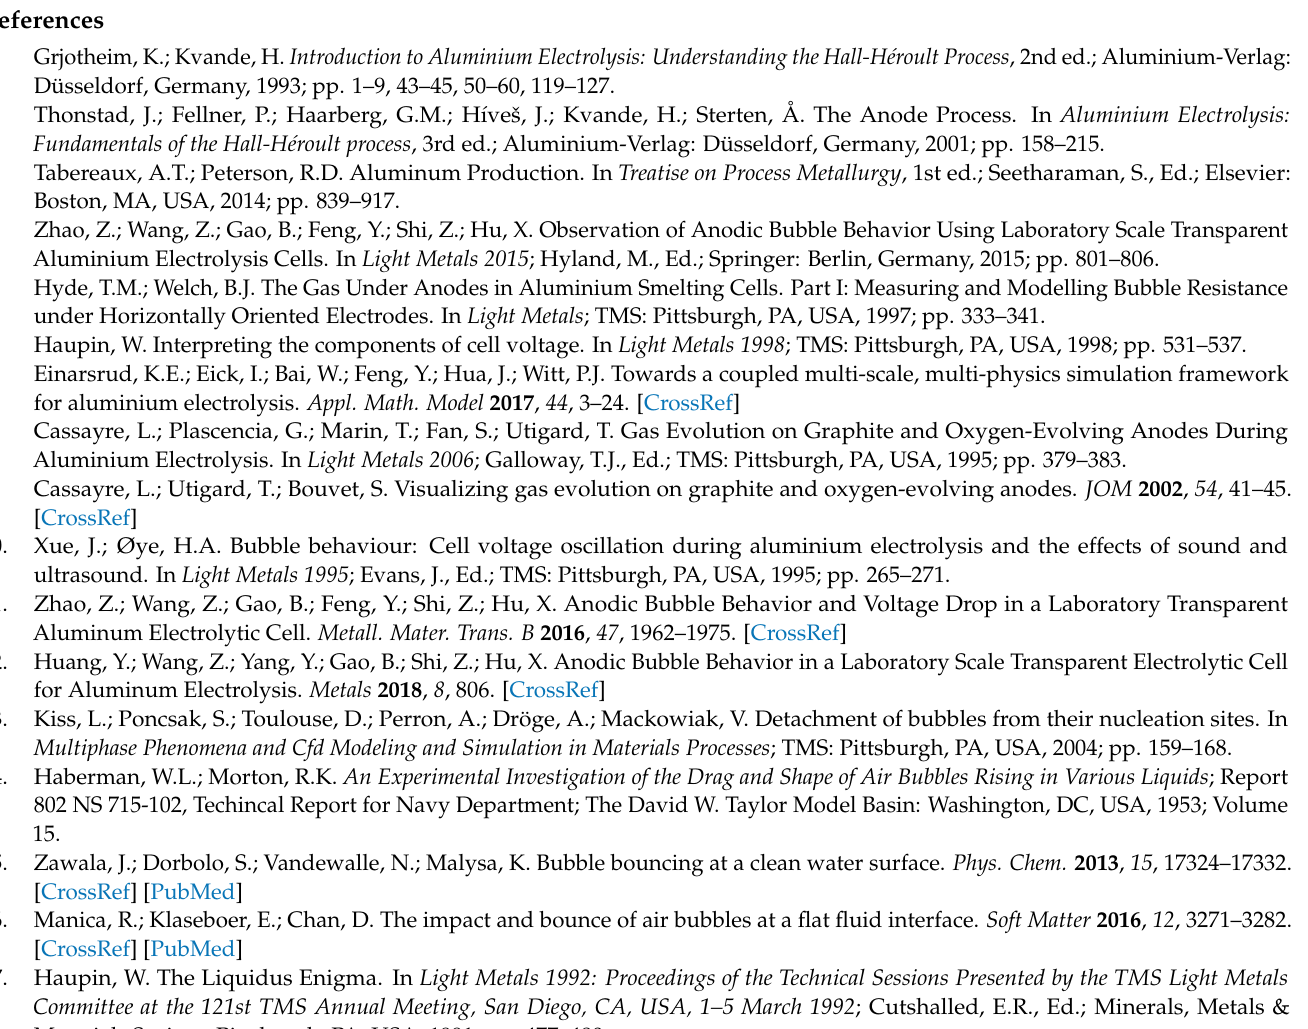
Figure A4. An example of measurement of lower and upper contact angle of the bubble just before detachment on the vertical anode during electrolysis at a constant current density of 0.5 A cm − 2 .